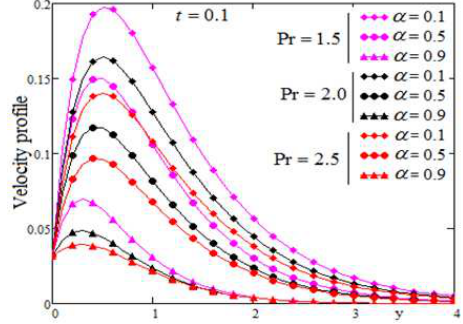
Figure 5. Profile of dimensionless velocity versus y for α variation with M = 0 . 4 , S = 5 , Sc = 0 . 8 , λ = 4 , Gr = 3 , Gm = 0 . 9 , and different values of Pr .